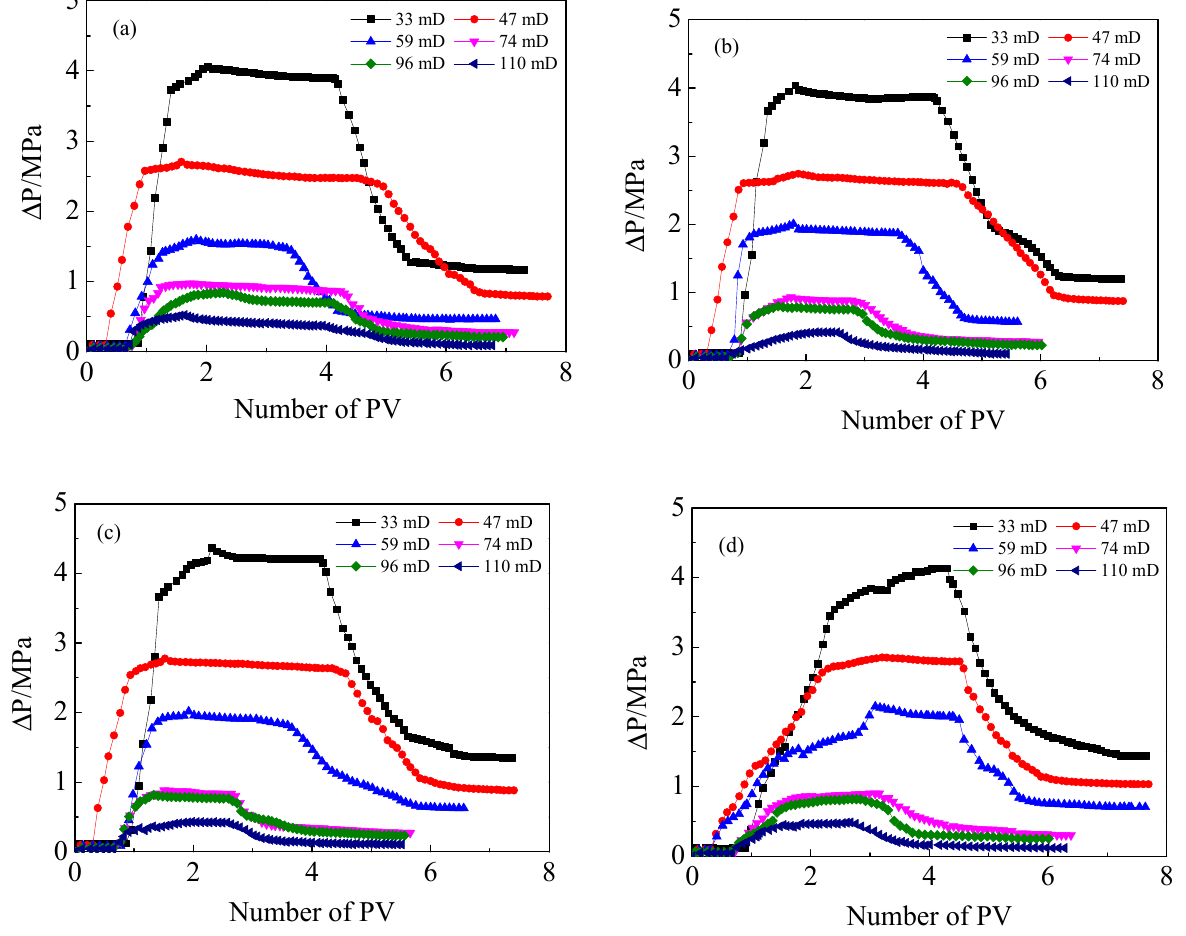
Figure 3. Pressure gradient ( ∆ P) as a function of pore volume (PV) of injected in LW-HPAM flow in different permeability cores. ( a ) 0.8 g · L − 1 , ( b ) 1.5 g · L − 1 , ( c ) 2.3 g · L − 1 and ( d ) 3.0 g · L − 1 .